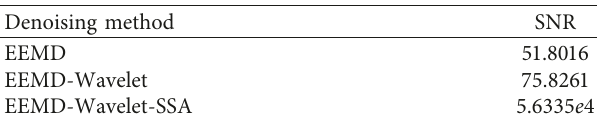
Table 2: Seismic signal denoising effect.